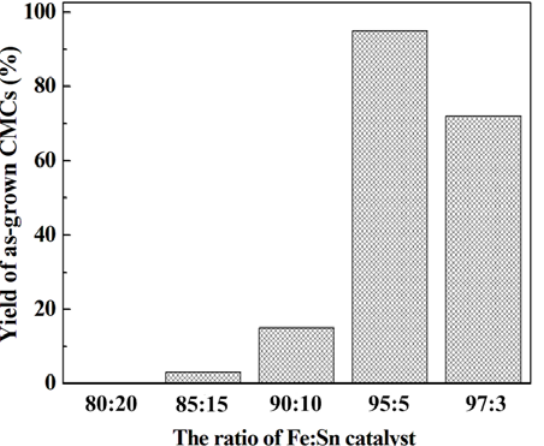
Figure 3. The yield ratio of as-grown CMCs vs . the different mass ratios of Fe-Sn catalytic